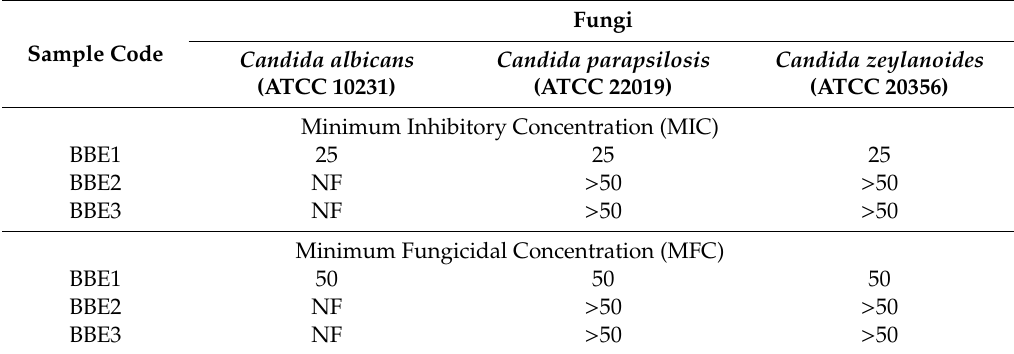
Table 7. Antifungal activity (mg / mL) of the beech bark extracts